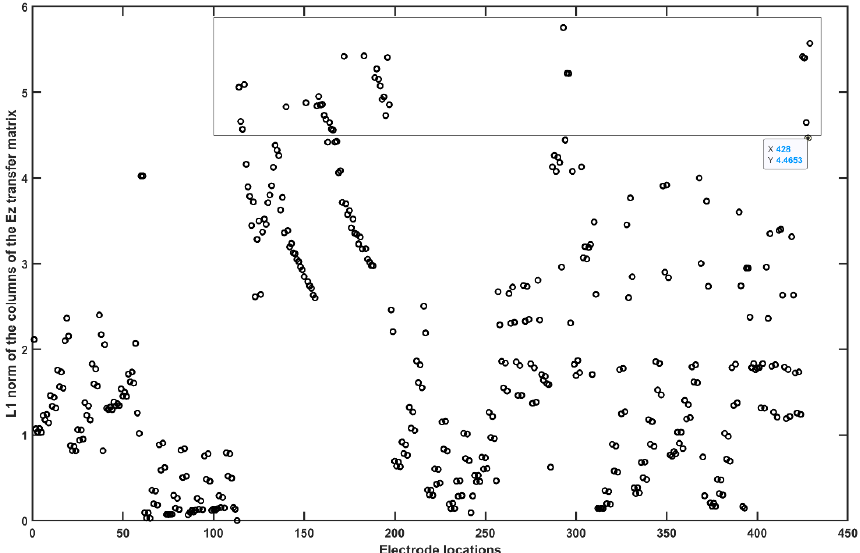
Figure A9 . L1 norm of the columns of the Ez transfer matrix without the non − cerebellar brain (i.e., row 35). The rectangle shows the electrode locations with the high L1 norm (electrodes relevant for cerebellar stimulation in Ez). Table A5. List of electrode locations relevant for cerebellar stimulation in Ez (L1 norm > 4.5).